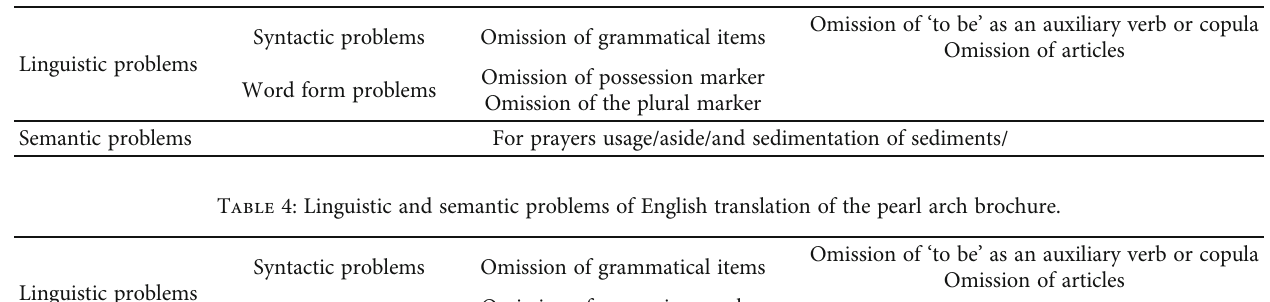
Table 3: Linguistic and semantic problems of English translation of the pond house of mosque brochure.